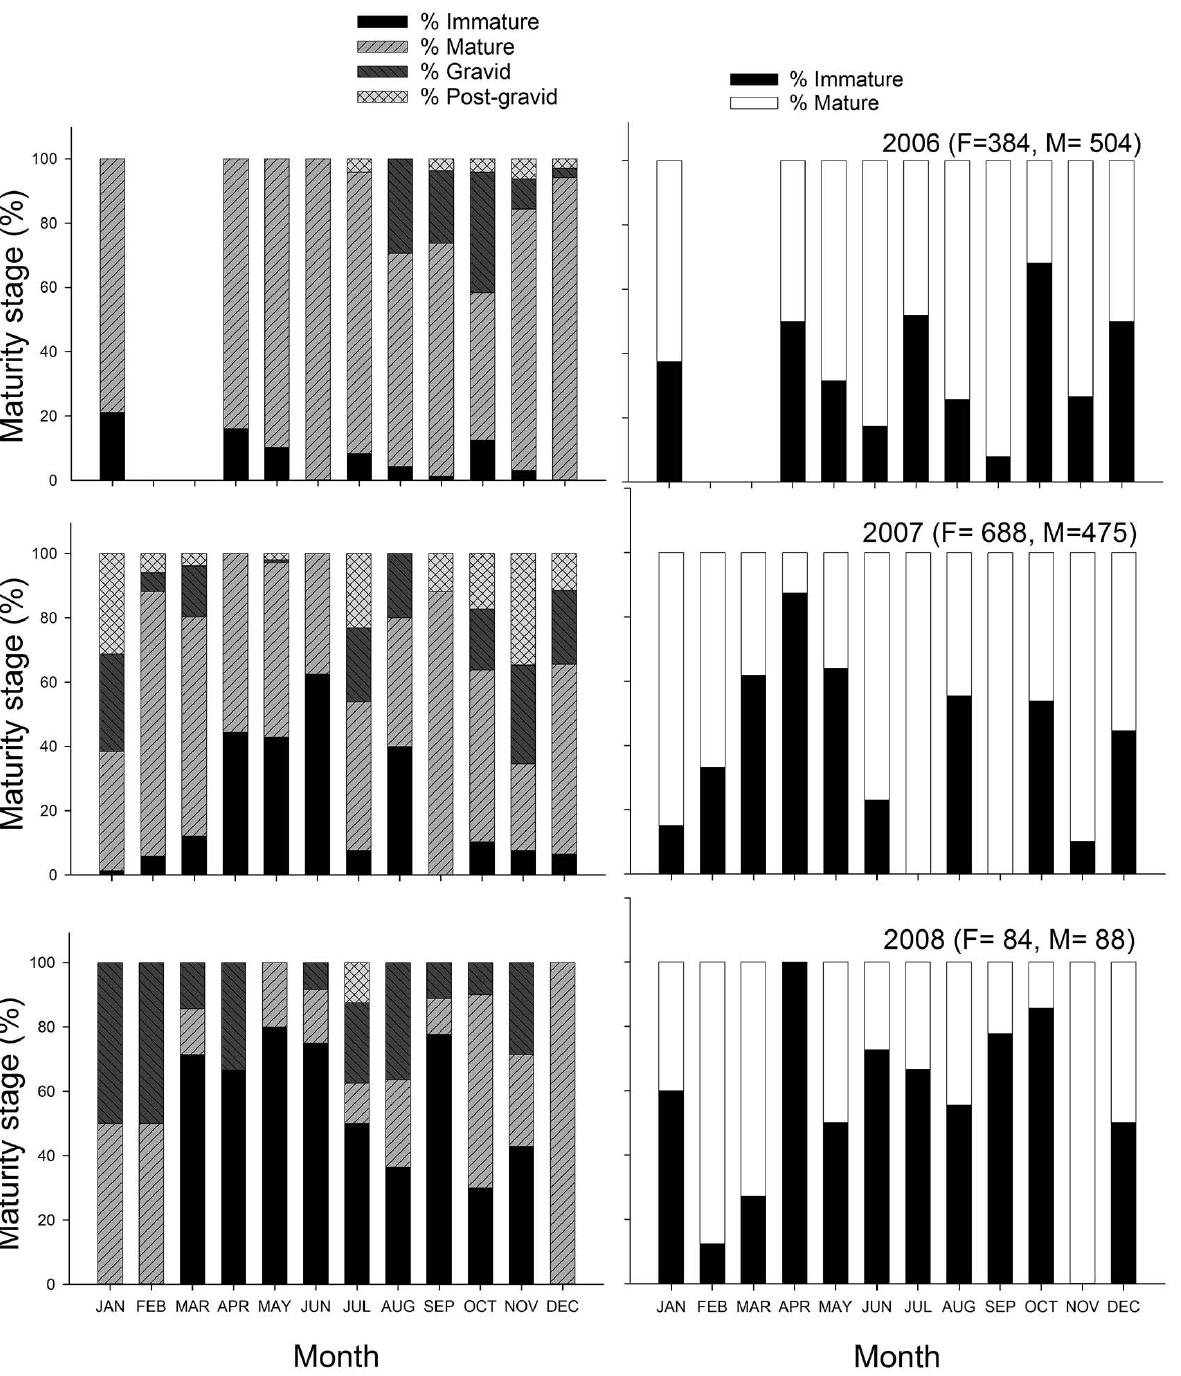
Fig. 3. – Maturity stages of females (left) and males (right) of Mustelus higmani captured by the artisanal fishery of Margarita Island, Ven- ezuela, from 2006 to